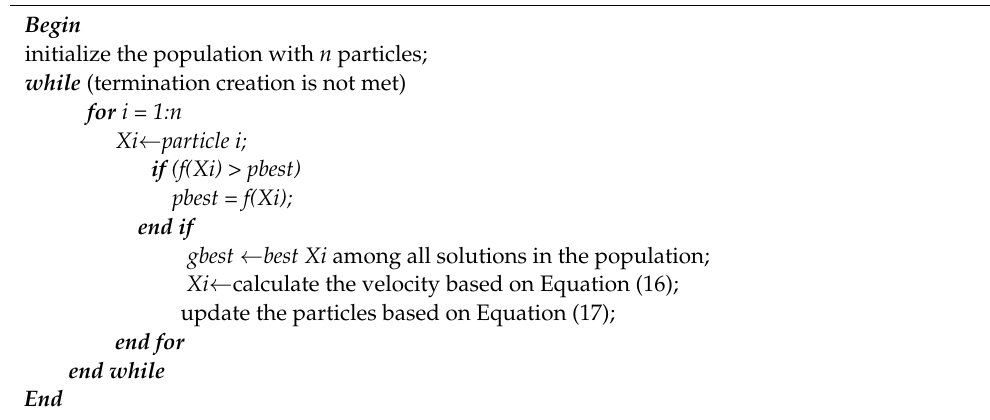
Algorithm 2: Pseudo-code of the PSO